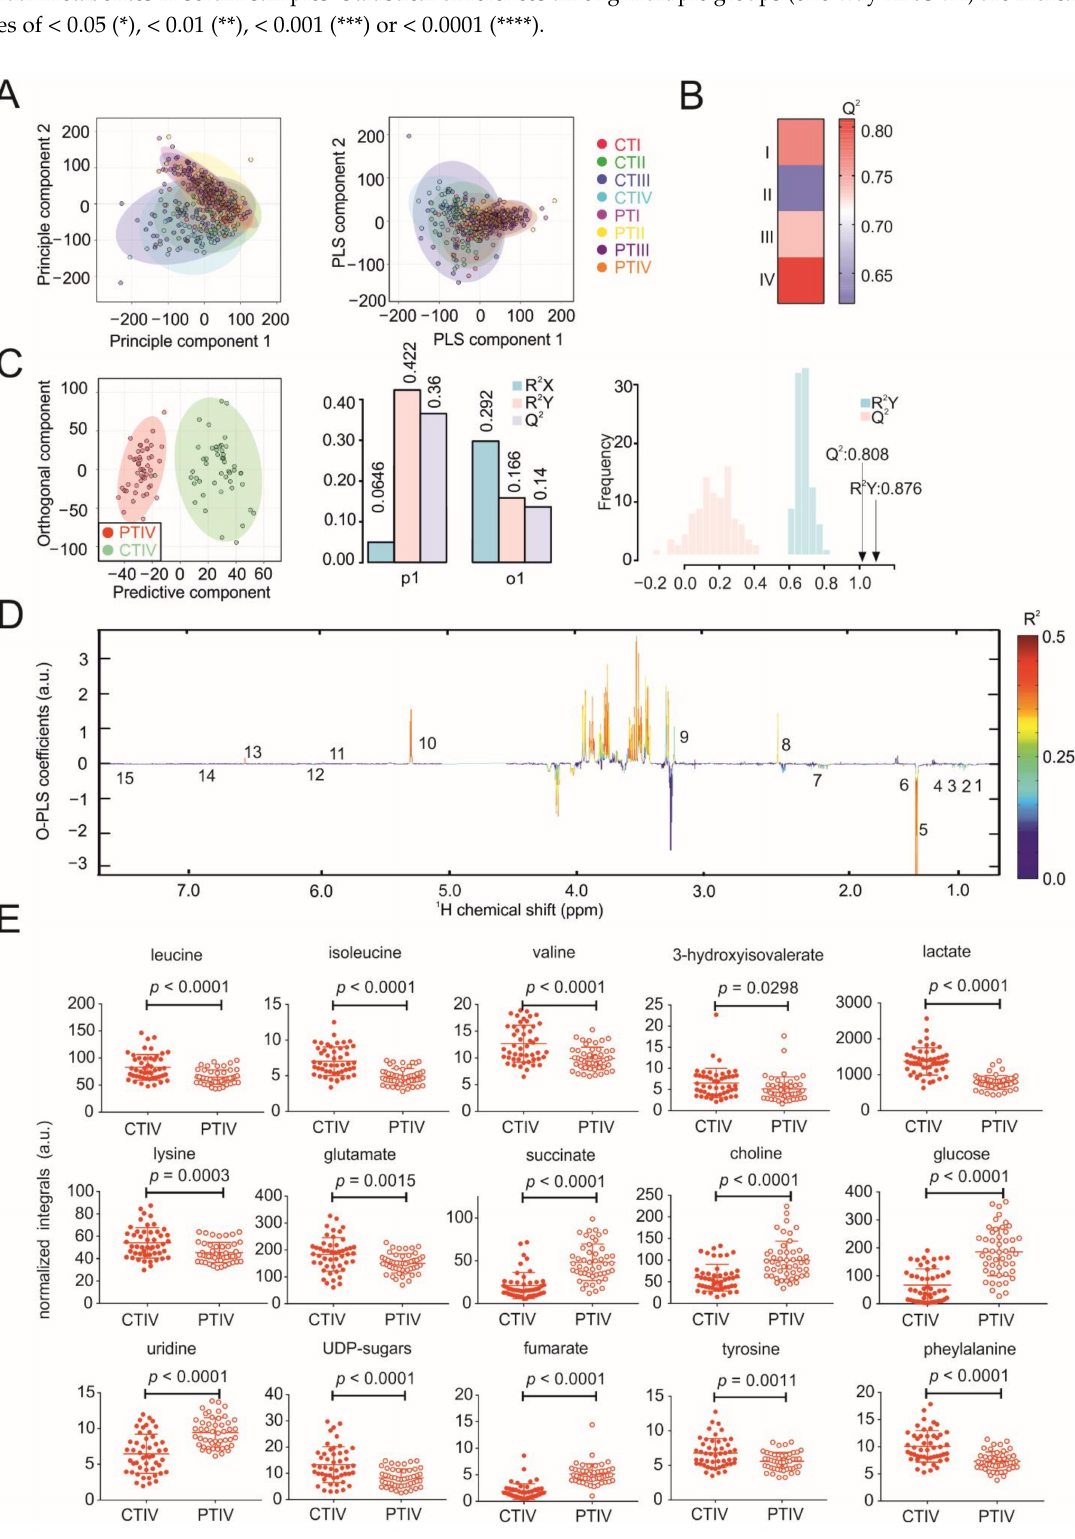
individual metabolites in serum samples. Statistical differences among multiple groups (one-way ANOVA) are indicated by